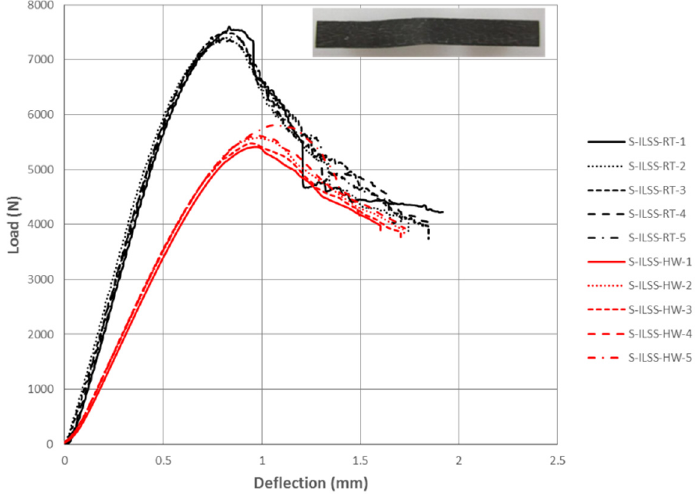
Figure 8. E ff ect of aging on load-deflection curves measured in ILSS test. Figure 8. Effect of aging on load-deflection curves measured in ILSS test.